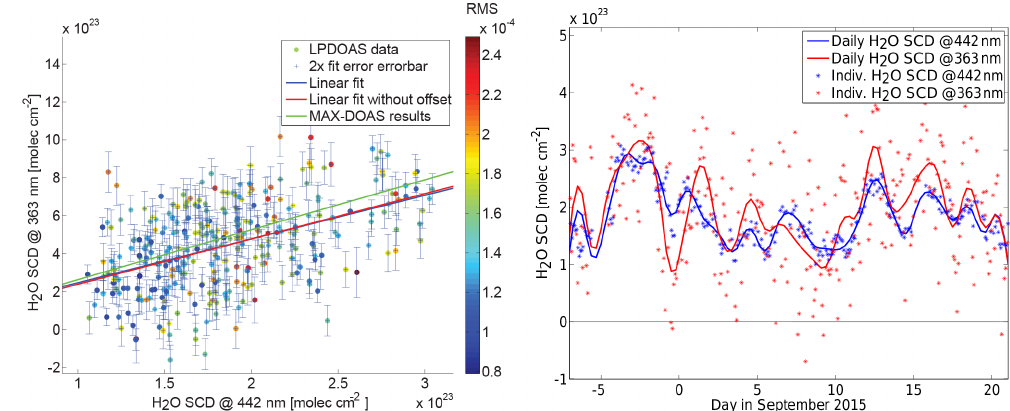
Figure 4. Left: correlation of H 2 O slant column densities (SCDs) from LP-DOAS measurements near 363 and 442nm. Also shown is the result from Table 3 line (1) from MAX-DOAS observations. Right: time series of H 2 O column densities from LP-DOAS measurements near 363 and 442nm. Values near 363nm were corrected by the scaling factor determined from the correlation plot on the